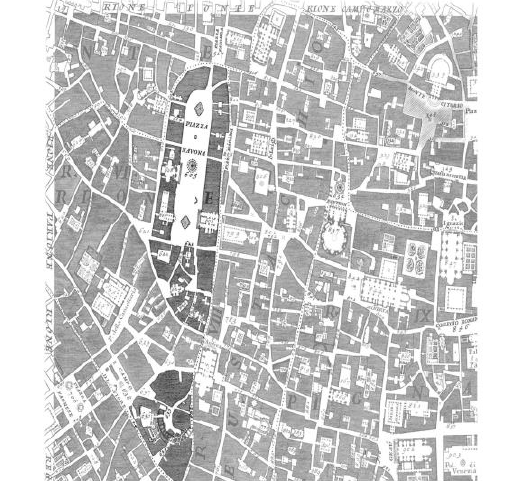
Figure 1. From the plan of (Nolli, 1748) it is evident the permanence of the shape of the ancient buildings in the modern city and their relationship with the paths